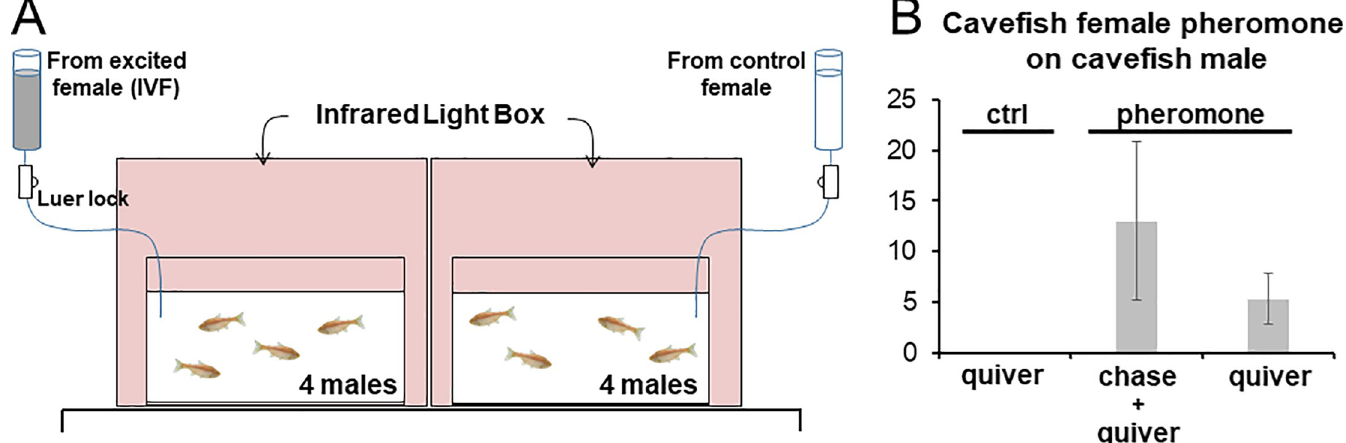
Fig 5. Effect of female pheromonal solution on male reproductive behavior. A, experimental setup. Two tanks with 4 males in each were recorded in parallel. To avoid interference with the perfusion system, the oxygenating pump was removed from the aquaria for this experiment. B, histogram showing the number of quivering, or chasing plus quivering events occurring during 5 minutes between cavefish males upon perfusion of control solution or female cavefish pheromonal solution (n = 3 groups each; mean ± SD per group).